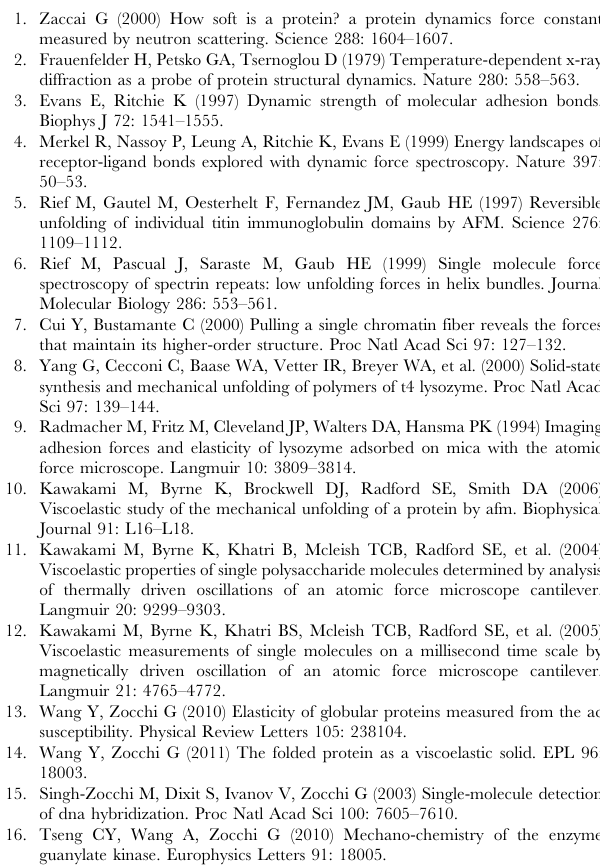
(circles) regimes, calculated from the data of Fig. 2 using eqs. 18 { 21 . (b) The loss modulus G 00 v ð Þ (the imaginary part of the complex modulus, arbitrary unit) of the protein z GNP system in the elastic (squares) and viscoelastic (circles) regimes, calculated as above. The real ‘‘storage/loss modulus’’ corresponding to 6 | 10 5 in the graph is * 5